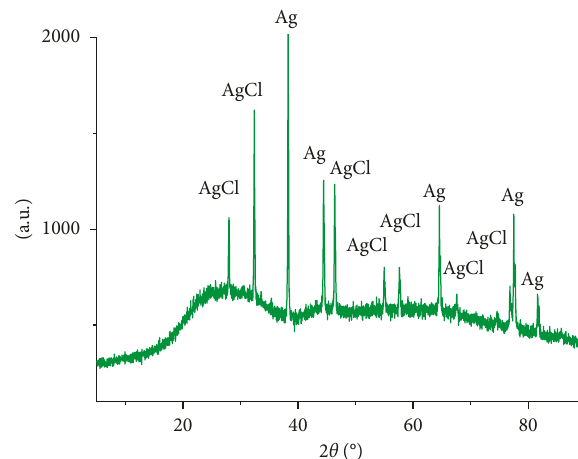
Figure 1: XRD pattern of the formed